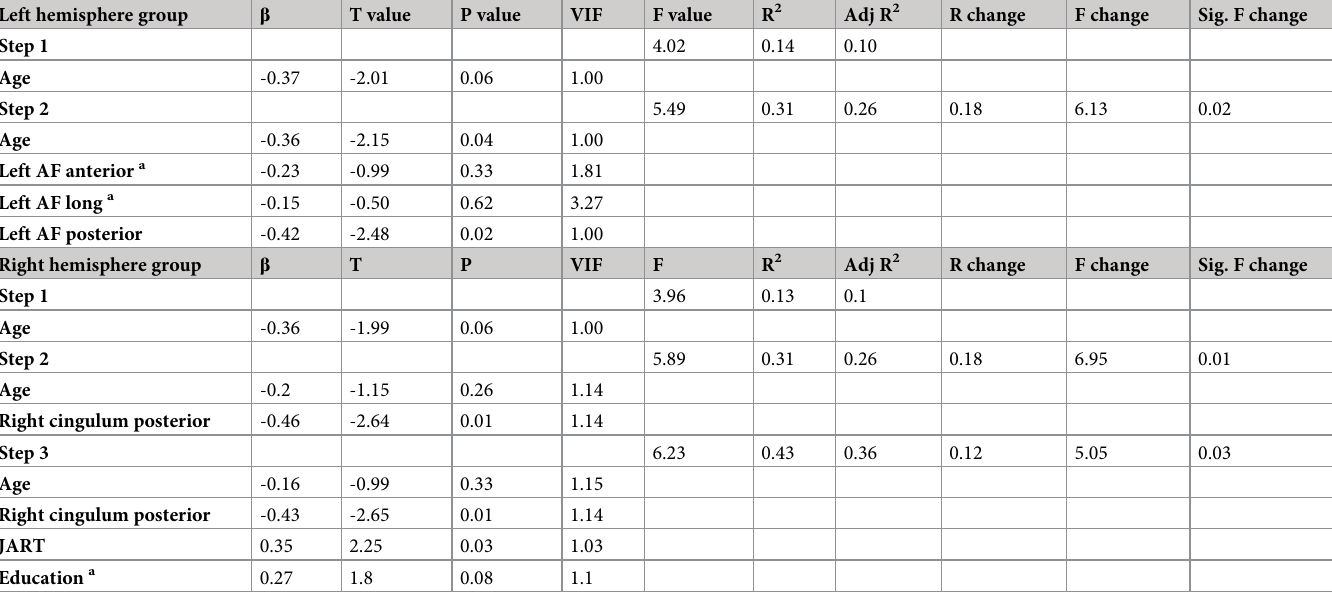
Table 2. The regression model of postoperative VSTM.